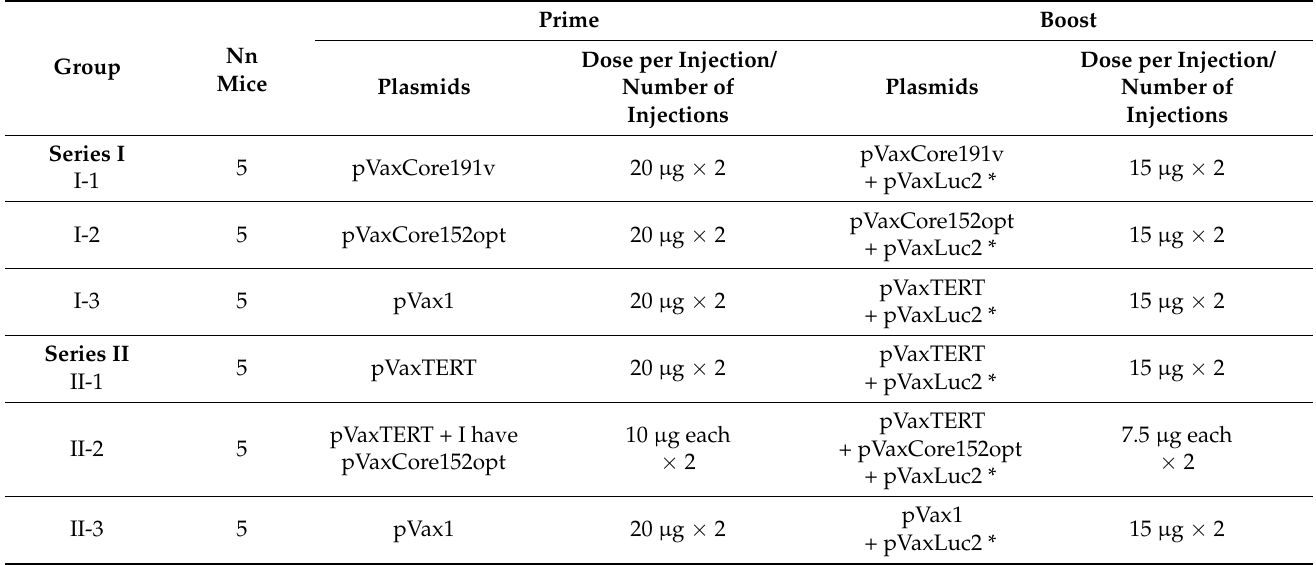
Table 1. DNA immunization